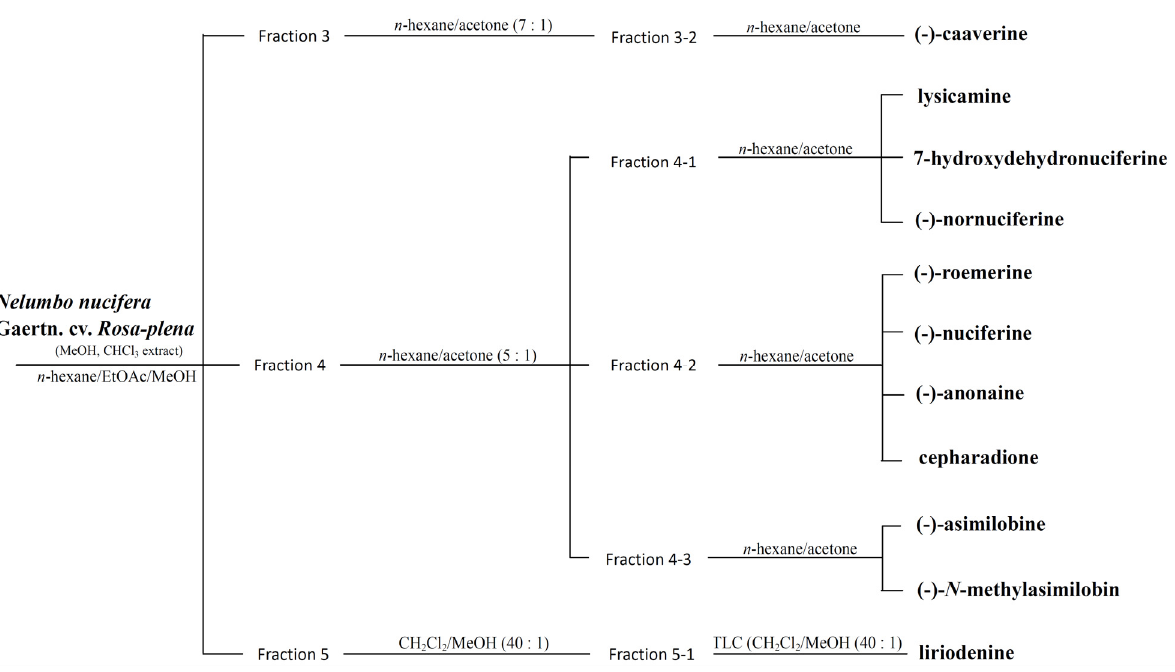
Figure 1. Schematic drawing of extraction from Nelumbo nucifera Gaertn. cv. Rosa-plena